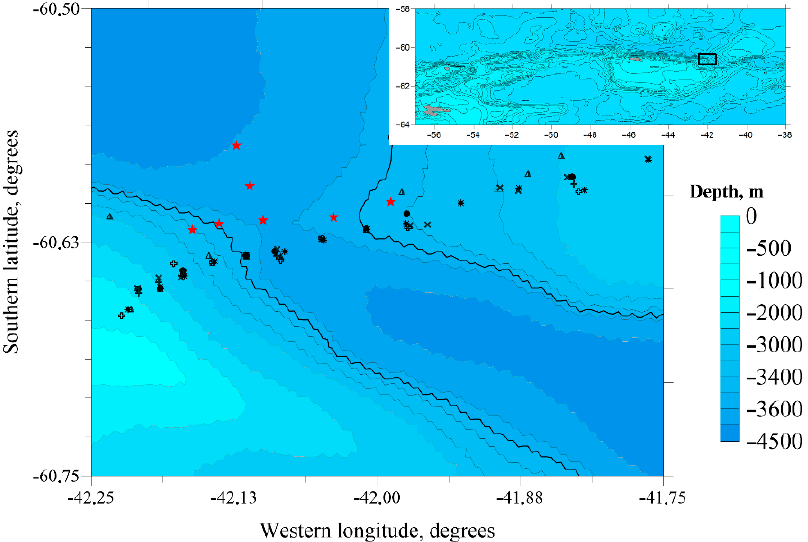
Figure 4. CTD/LADCP casts in the Orkney Passage in different years. Red stars indicate our stations in 2022. A chart of the region is shown in the inset. Black symbols indicate previous stations of CTD-casts in different